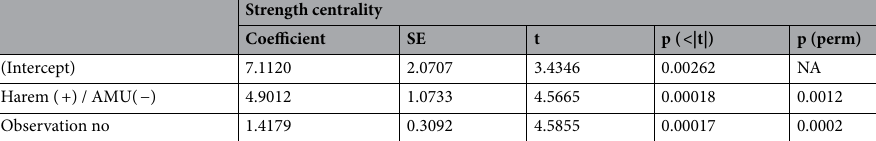
Table 2. The result of regression analysis on strength centrality of harems and AMUs. p ( <|t|) is based on the t value as a normal consequence of linear regression without permutation and p (perm) is calculated based on the permutation.